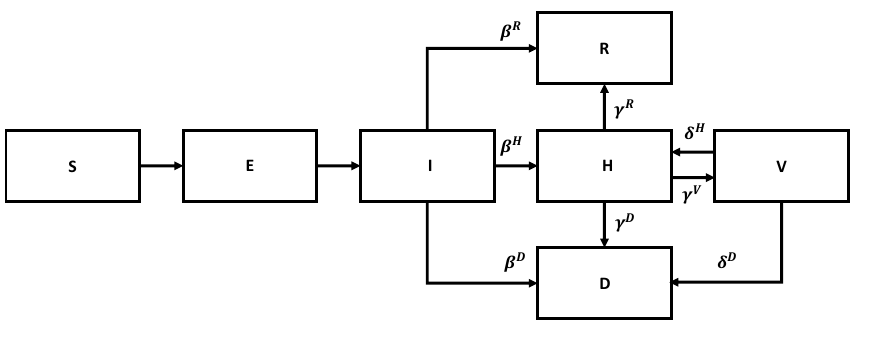
Figure 6. Flow chart for the SEIR model. Susceptible members become exposed upon contact with infected members, exposed become infected after a period, stay infected for a while, and then either recover or die or are admitted to the hospital. Similar stages take place after hospitalization, as per the previous diagram. In a sense, we are dealing with a version of Kirchhoff’s